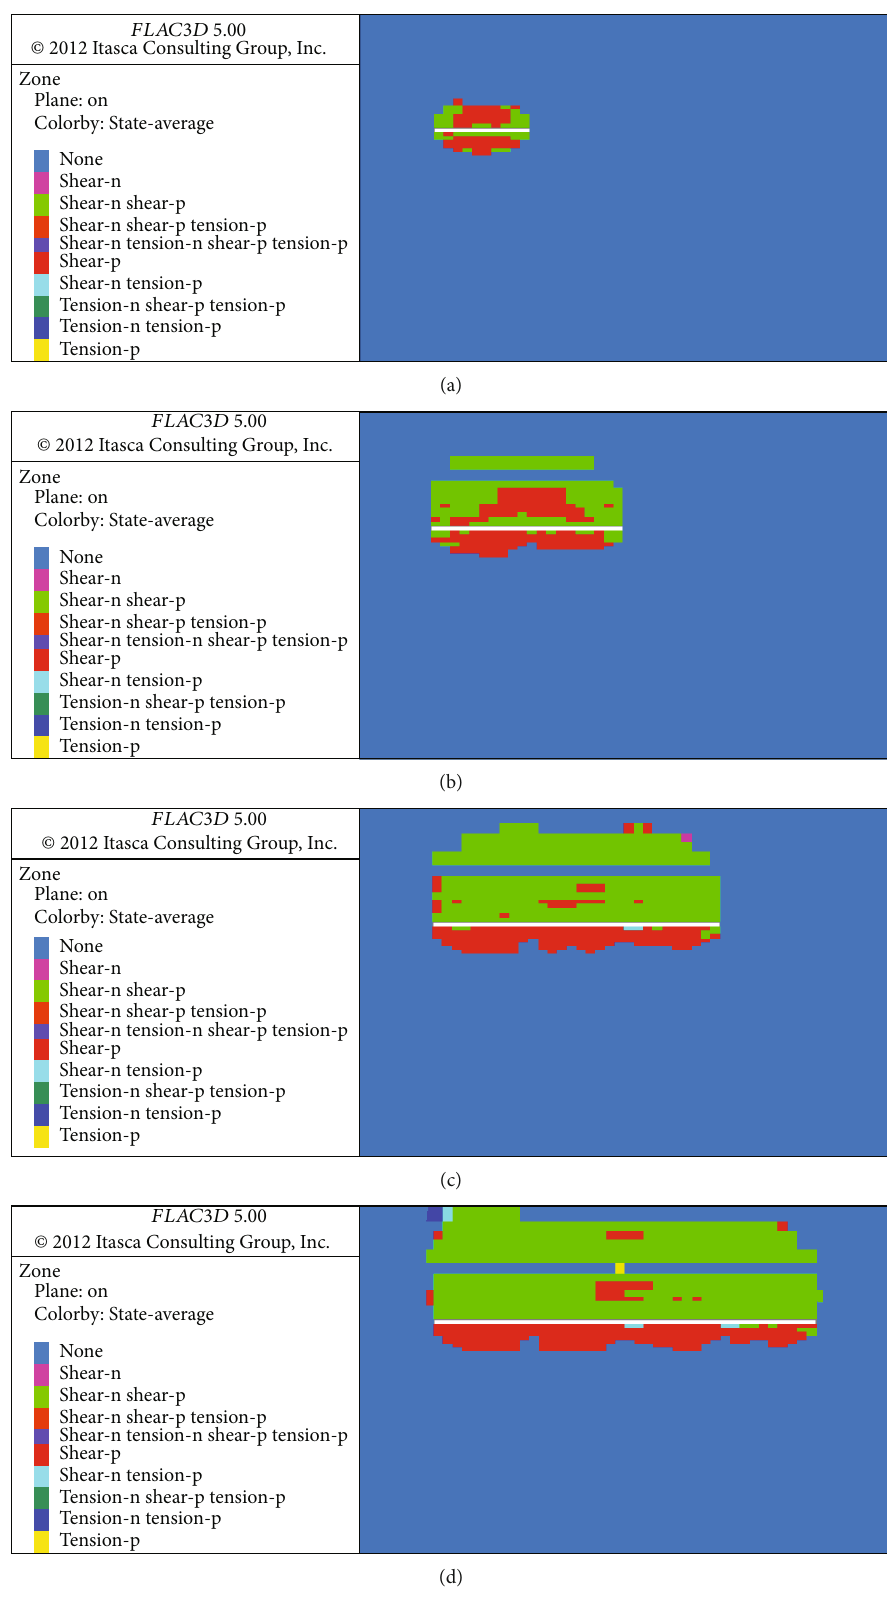
Figure 19: Cloud diagrams of the plastic zone changes in the propulsion of the W coal seam when the working face is pushed to (a) 100 m, (b) 200m, (c) 300 m, and (d)